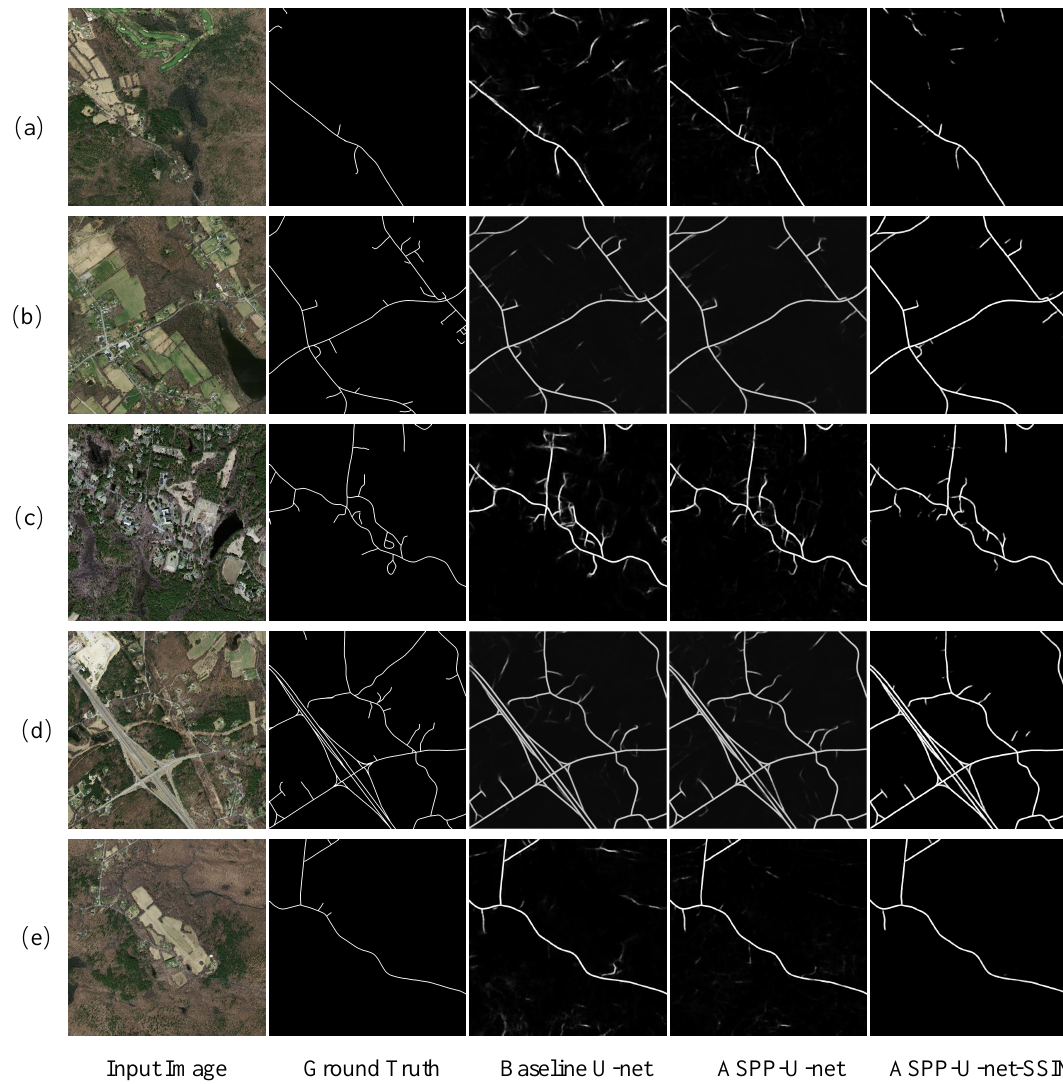
Figure 7. Visualization results of three models in the test set of the Massachusetts road dataset: The brightness of the results represents the confidence of the predicted results. For each row in ( a )–( e ), it contains an input image, a ground truth image and three result maps of a sample